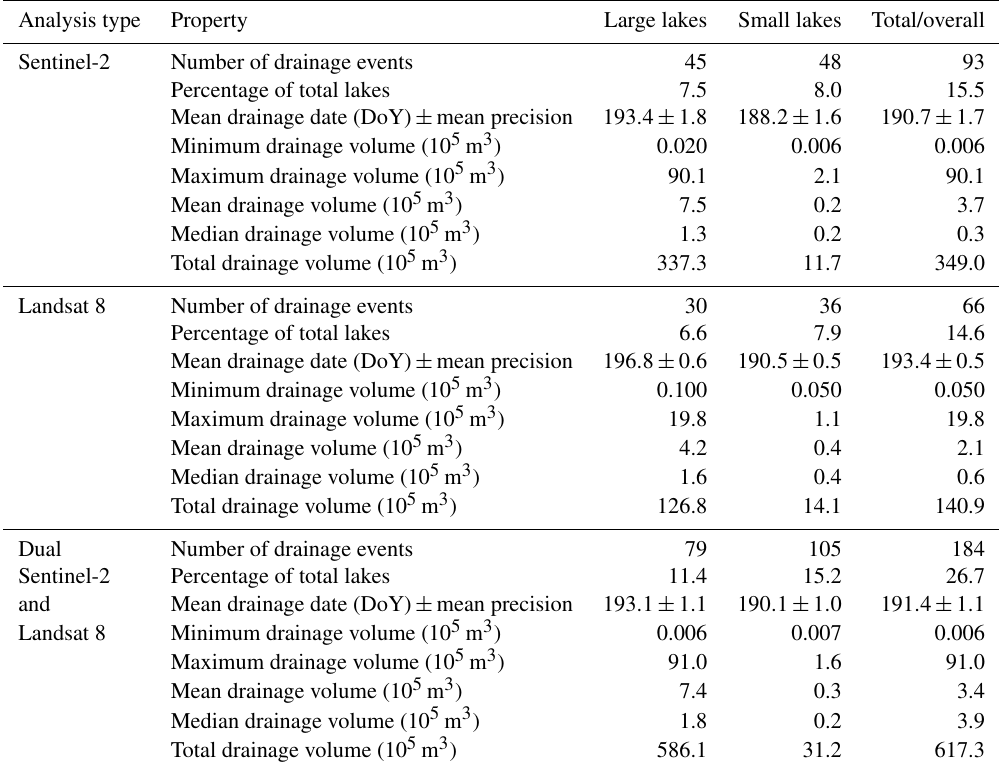
Table 2. Properties of rapid-lake-drainage events identified using the satellite datasets individually and as part of a dual-satellite dataset. Large lakes are defined as ≥ 0 . 125km 2 (identifiable by MODIS), while small lakes are defined as < 0 . 125km 2 (omitted by MODIS). “DoY” refers to the day of year in